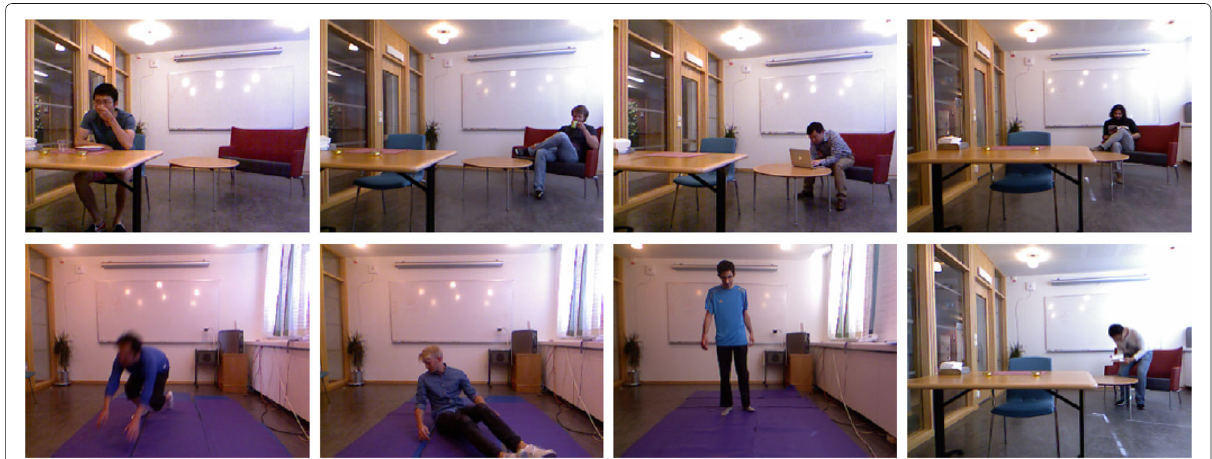
Fig. 4 Key frames from Dataset-A containing activities from 8 classes. Upper row from left to right: eating , drinking , usinglaptop , and reading . Lower row from left to right: fallingdown , lyingdown , walking , and sittingdown